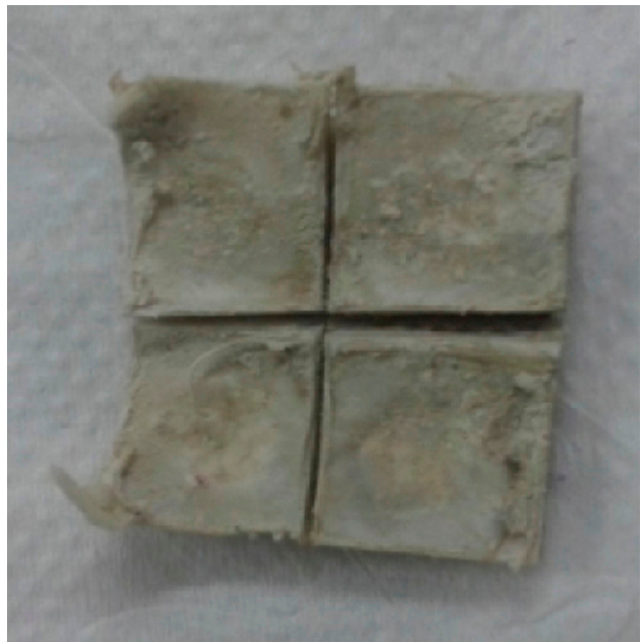
Figure 4. The cabbits calvaria after 8 weeks of healing divided into 4 pieces for histology and CT.